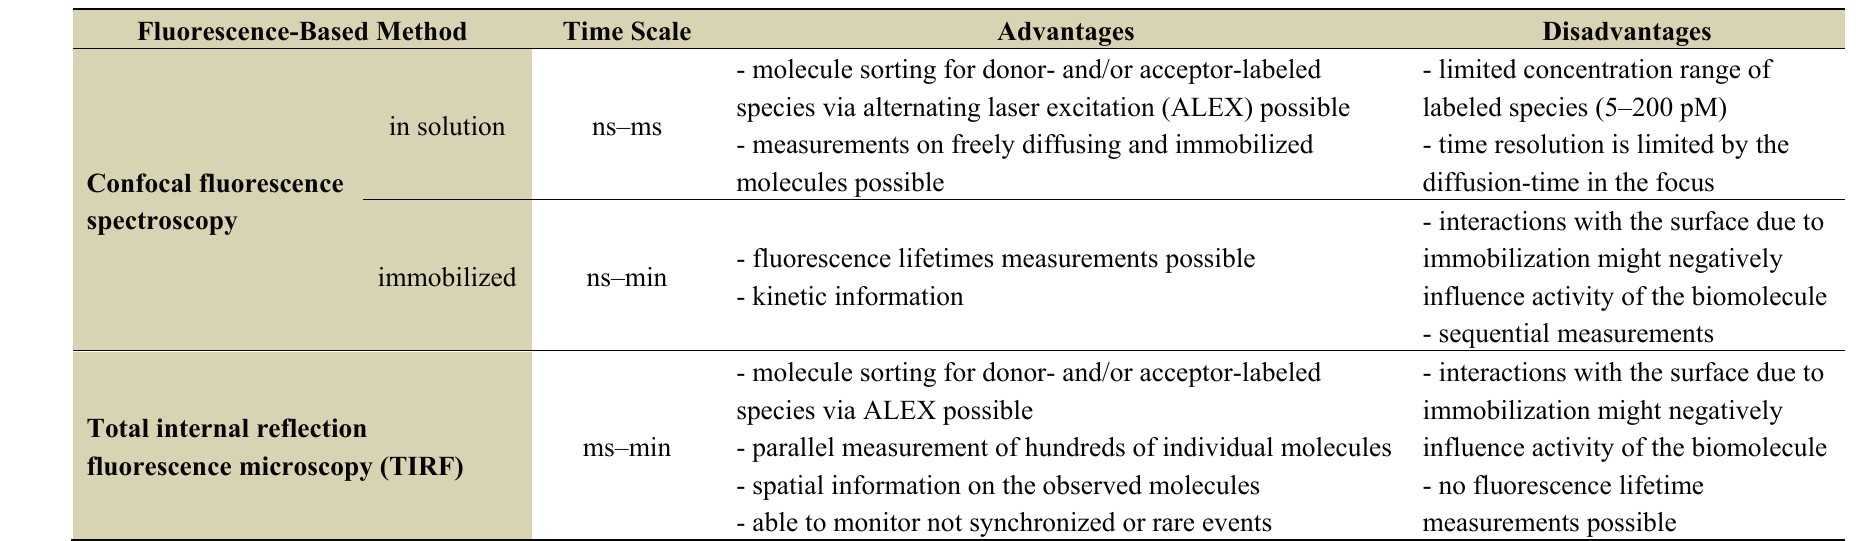
Table 2. Fluorescence-based methods commonly used to analyze biomolecular interactions, stoichiometries and dynamics in the nanosecond to minute time range. Commonly, confocal fluorescence spectroscopy and total internal reflection (TIRF) spectroscopy are used to analyze the dynamics of single molecules and to measure intra- or intermolecular distances via